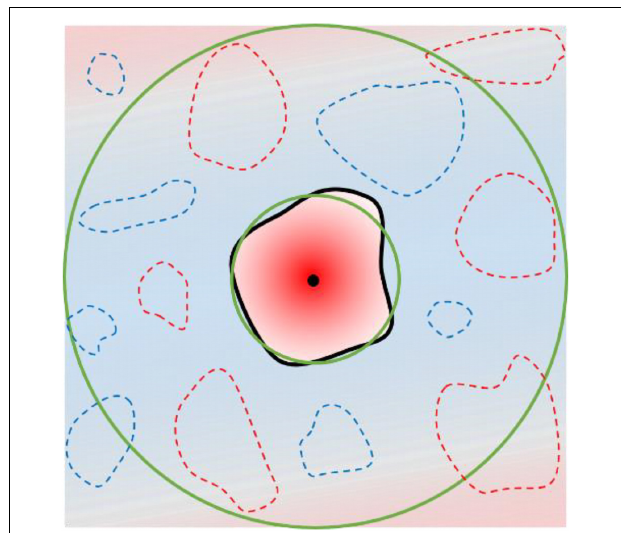
FIGURE 8 | Schematic diagram showing the eddy reconstruction process. The eddy under study is indicated by the area enclosed by the thick black curve, with the black dot representing its body center. The two green circles show the equivalent circle and the ambient circle, i.e., a circle with 3 times the radius of the equivalent circle. When reconstructing, the eddy anomaly is assigned to the body center, and decreases linearly in the radial direction toward the boundary. Dashed curves indicate other eddies, either with positive (red) or negative (blue) anomalies. The shading in the background is to indicate the large-scale imprint left over after removing the climatology, and is not present in the reconstructed eddy